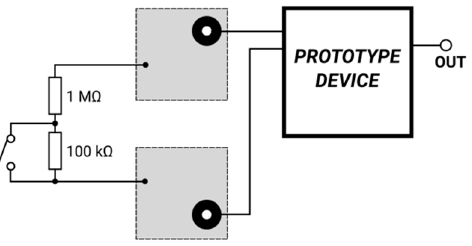
Figure 3. Experimental setup including Ag/AgCl electrode interface (self-adhesive electrodes at- tached to stainless steel plates) used in assessment of slew rate of the prototype device.